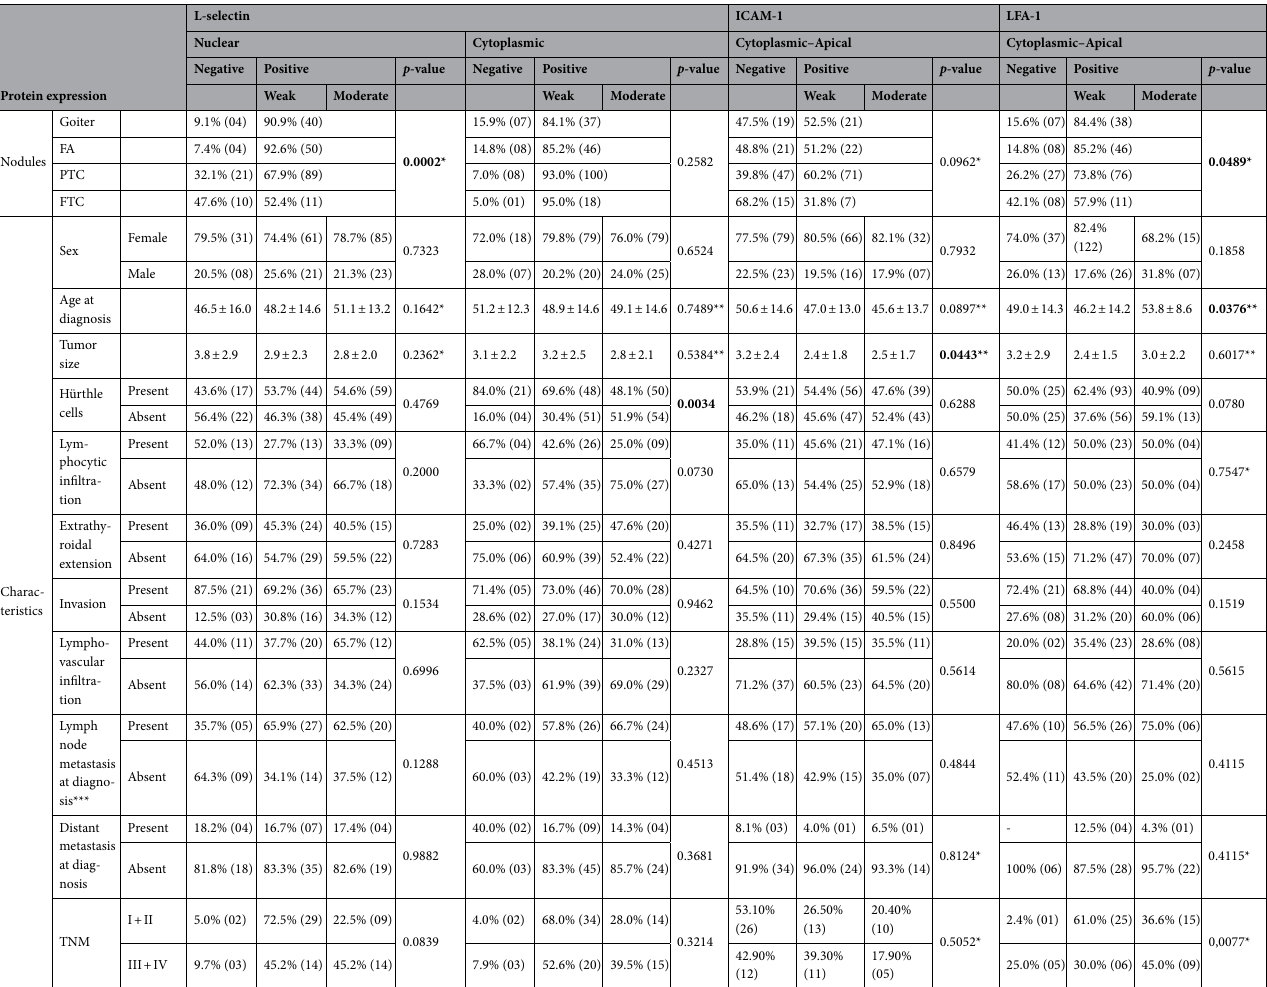
Table 2. L-selectin, ICAM-1 and LFA-1 protein expression in 275 thyroid nodule patients and clinical features—% (N). Chi-square test; *Fisher’s exact test; **Mann–Whitney test, ***Lymph node metastasis at diagnosis was restricted to PTC cases. FA Follicular Adenoma; PTC Papillary thyroid cancer; FTC Follicular thyroid cancer. Significant values are in